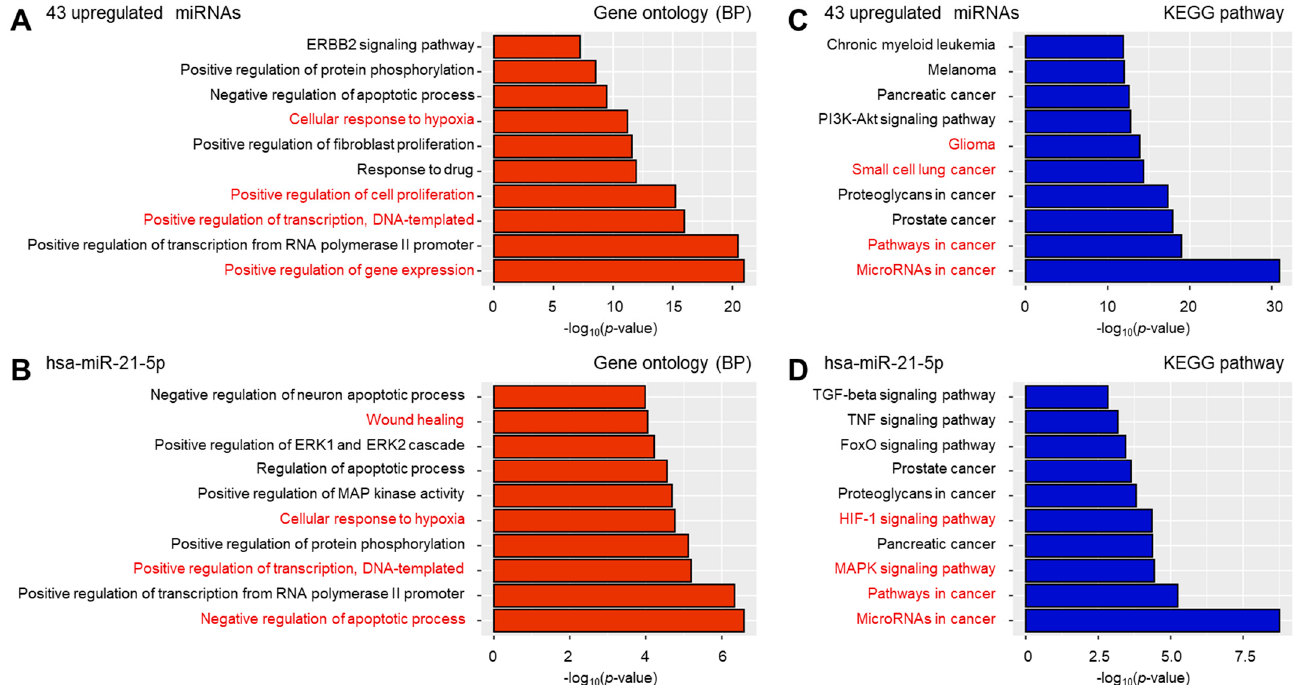
Figure 5. Analysis of the miRNA target gene enriched pathway. The experimentally validated target genes of 43 upregulated miRNAs ( A , C ) or hsa-miR-21-5p ( B , D ) were searched from miRTargetLink Human database. The target gene enriched pathways were computed from the Database for Annotation, Visualization and Integrated Discovery (DAVID). Bar graph depicted the top 10 highly enriched and biologically relevant pathways on Gene Ontology (GO) and Kyoto Encyclopedia of Genes and Genomes (KEGG) pathway. BP, biological processes.